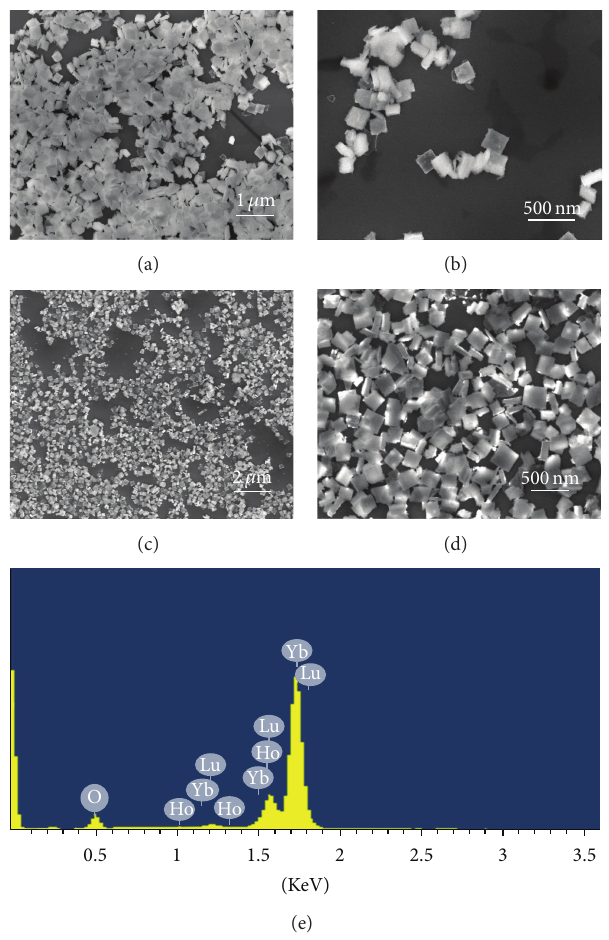
Figure 2: FE-SEM images of the as-prepared precursor Lu(OH) 3 :Yb 3+ , Ho 3+ : (a) low magnification, (b) high magnification and obtained FE-SEM images of target Lu 2 O 3 :Yb 3+ , Ho 3+ , (c) low magnification, (d) high magnification, and (e) EDS of the obtained Lu 2 O 3 :Yb 3+ , Ho 3+ nanocubic